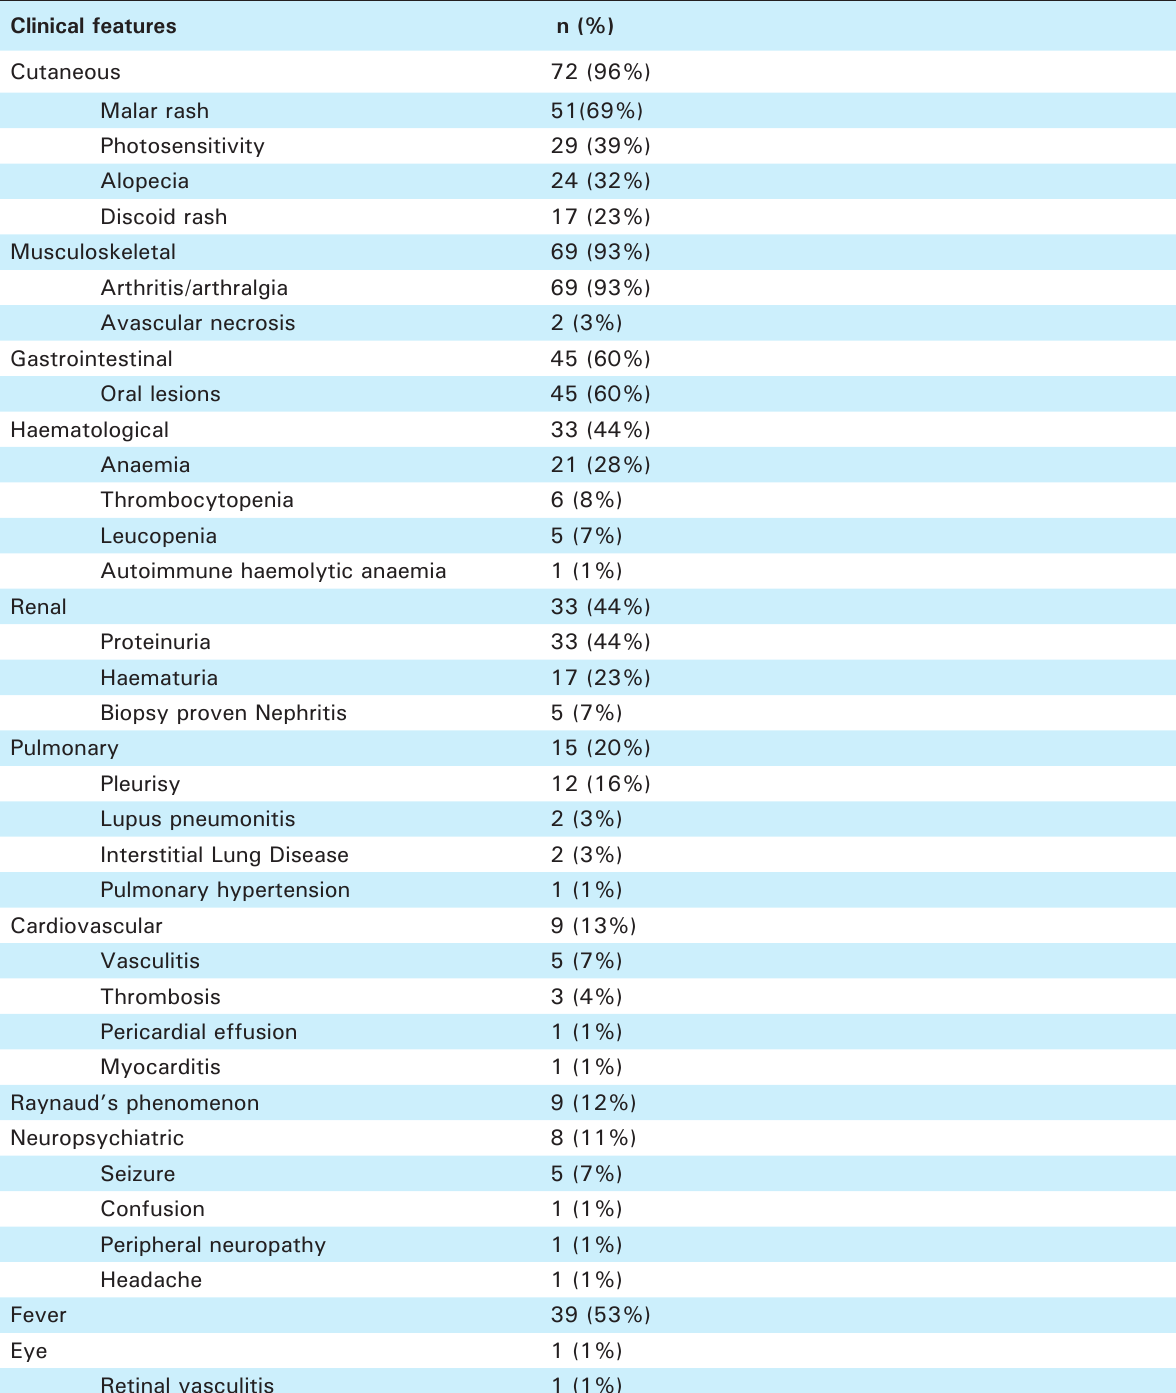
Table 1. The cumulative prevalence of organ/ system involvement and clinical manifestations of lupus patients.* Clinical